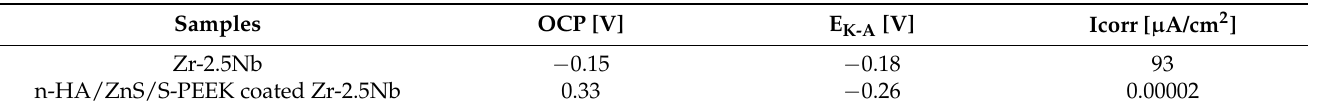
Table 2. Corrosion parameters for Zr-2.5Nb and coated alloy obtained from the analysis of OCP and polarization